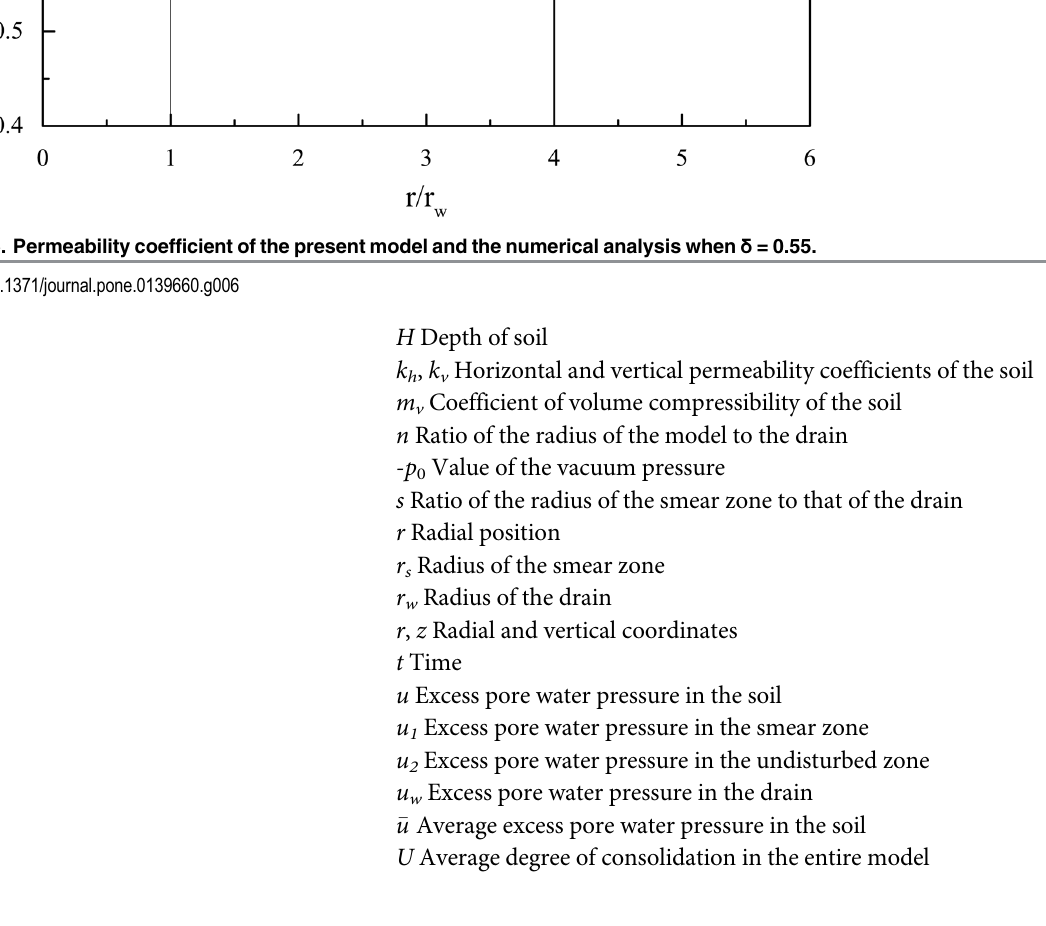
S2 Fig. Data of Fig 5(A).